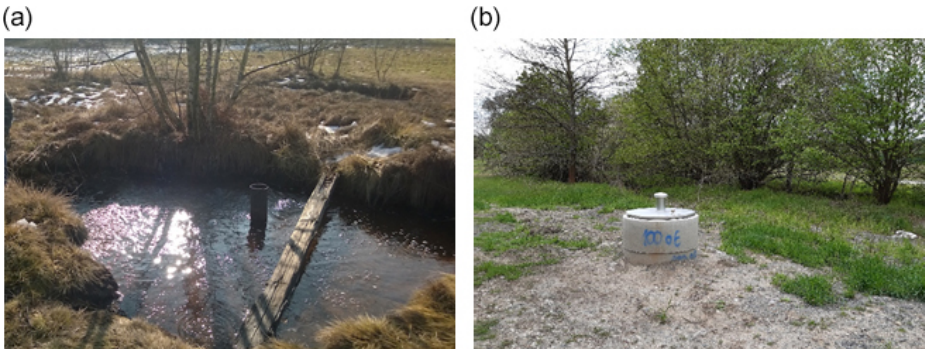
Figure 4. Panel (a) shows the Hartoušov mofette field, and panel (b) presents the F3 borehole in Hartoušov after the completion of drilling works, with the concrete head casing secured by a